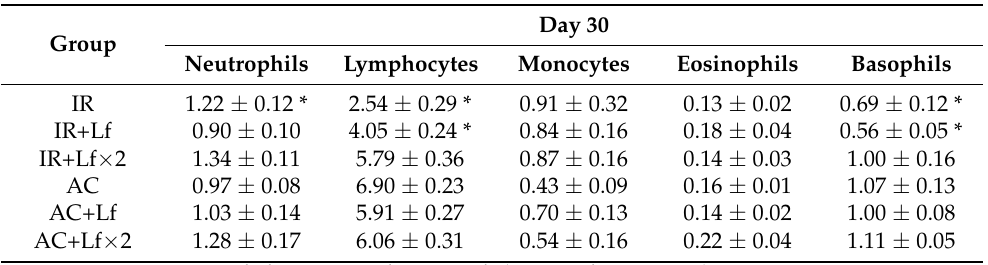
Table 2. Absolute number of leukocytes of different types in the blood of mice on day 30 after 7.5 Gy gamma irradiation ( × 10 6 /mL), Mean ±